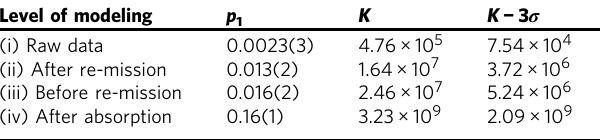
Depending on the level of modeling the inef fi ciencies of the experimental setup, different values for p 1 and hence for K are obtained (cf. Fig. 2b). By sampling p 1 , p 2 , and N around the measured values within the estimated uncertainties, we calculate the expected entanglement depth K . The values in the last columns are lower bounds on K with con fi dence 3 σ =